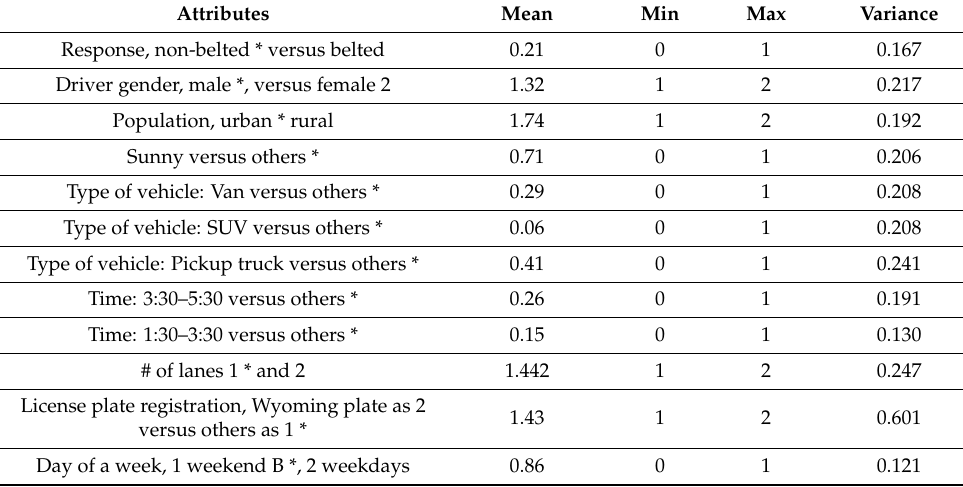
Table 1. Summary statistics of the considered